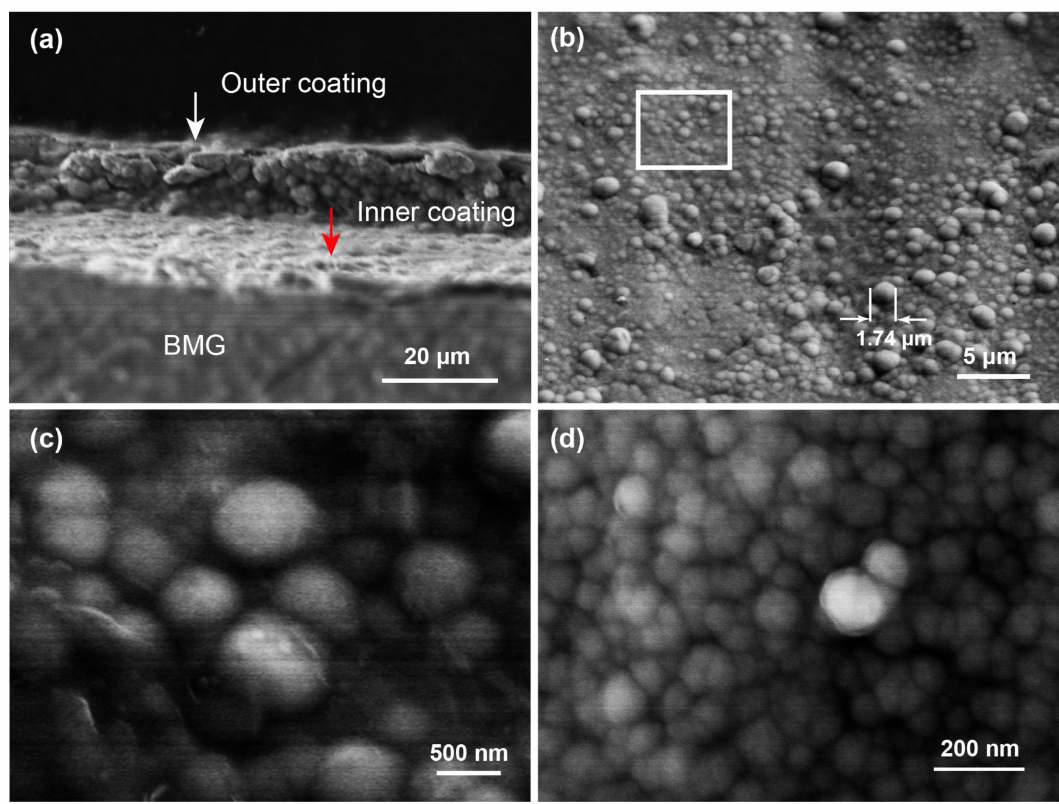
Figure 2. Scanning electron microscope (SEM) images showing the morphology of the electroless Ni coating on the surface of Ti-based BMG rod. ( a ) SEM image of the peeling off part showing layered structure of the coating; ( b ) Surface morphology of the outer coating; ( c ) Higher magnification image on the white square in ( b ); and, ( d ) Surface morphology of the outer